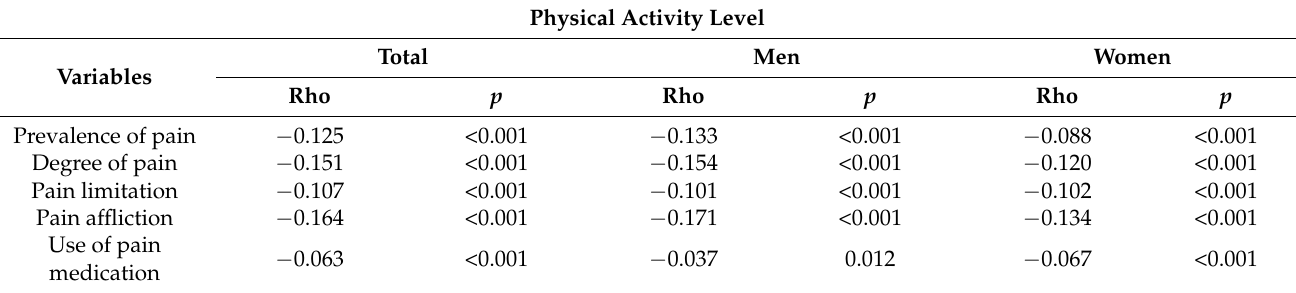
Table 1. Relationships between level of physical activity and prevalence of pain, degree of pain, pain limitation, level of pain impairment and use of pain medication in the Spanish population in